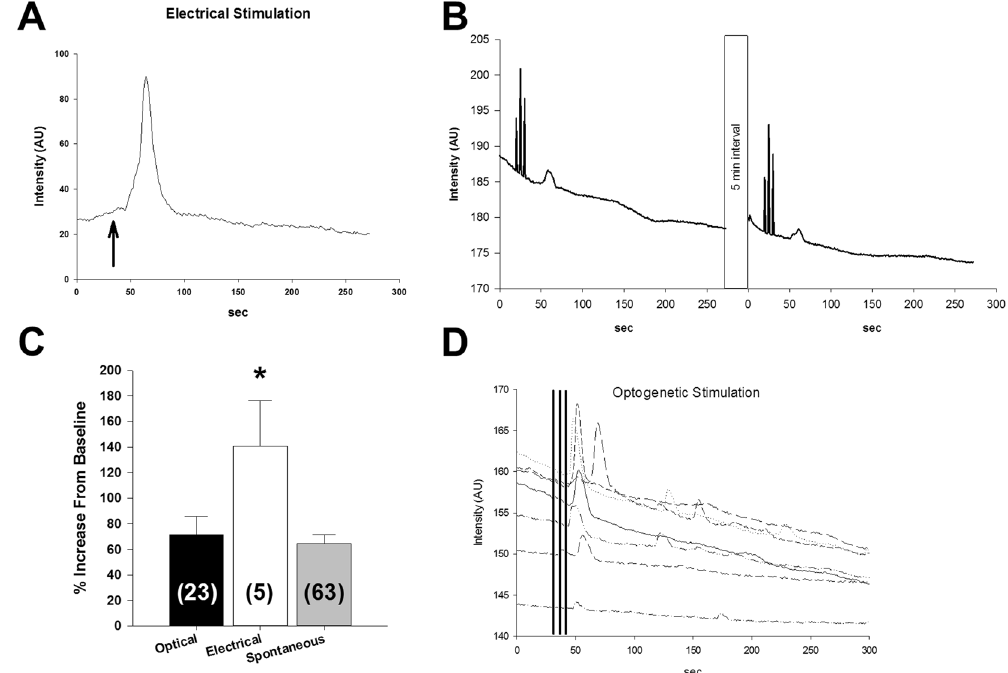
Figure 4. Sniffer cells respond to both electrically and optogenetically evoked ANG II release. ( A ) The SFO was electrically stimulated (arrow) and evoked release of AT1aR agonist that was detected in the MnPO. ( B ) The SFO was stimulated with 590 nm light and evoked release of AT1aR agonist that was detected in the MnPO with GCaMP + AT1aR sniffer cells. The light evoked sniffer cell response was reproducible. ( C ) Summary of GCaMP + AT1aR sniffer cell responses from in vitro slices. Optogenetic stimulation produced responses similar in magnitude to spontaneous events. Electrical stimulation produced responses that were greater than both light-evoked or spontaneous responses. ( D ) The SFO was stimulated with 470 nm light and evoked release of AT1aR agonist that was detected in the MnPO with R-GECO + AT1aR sniffer cells. * p